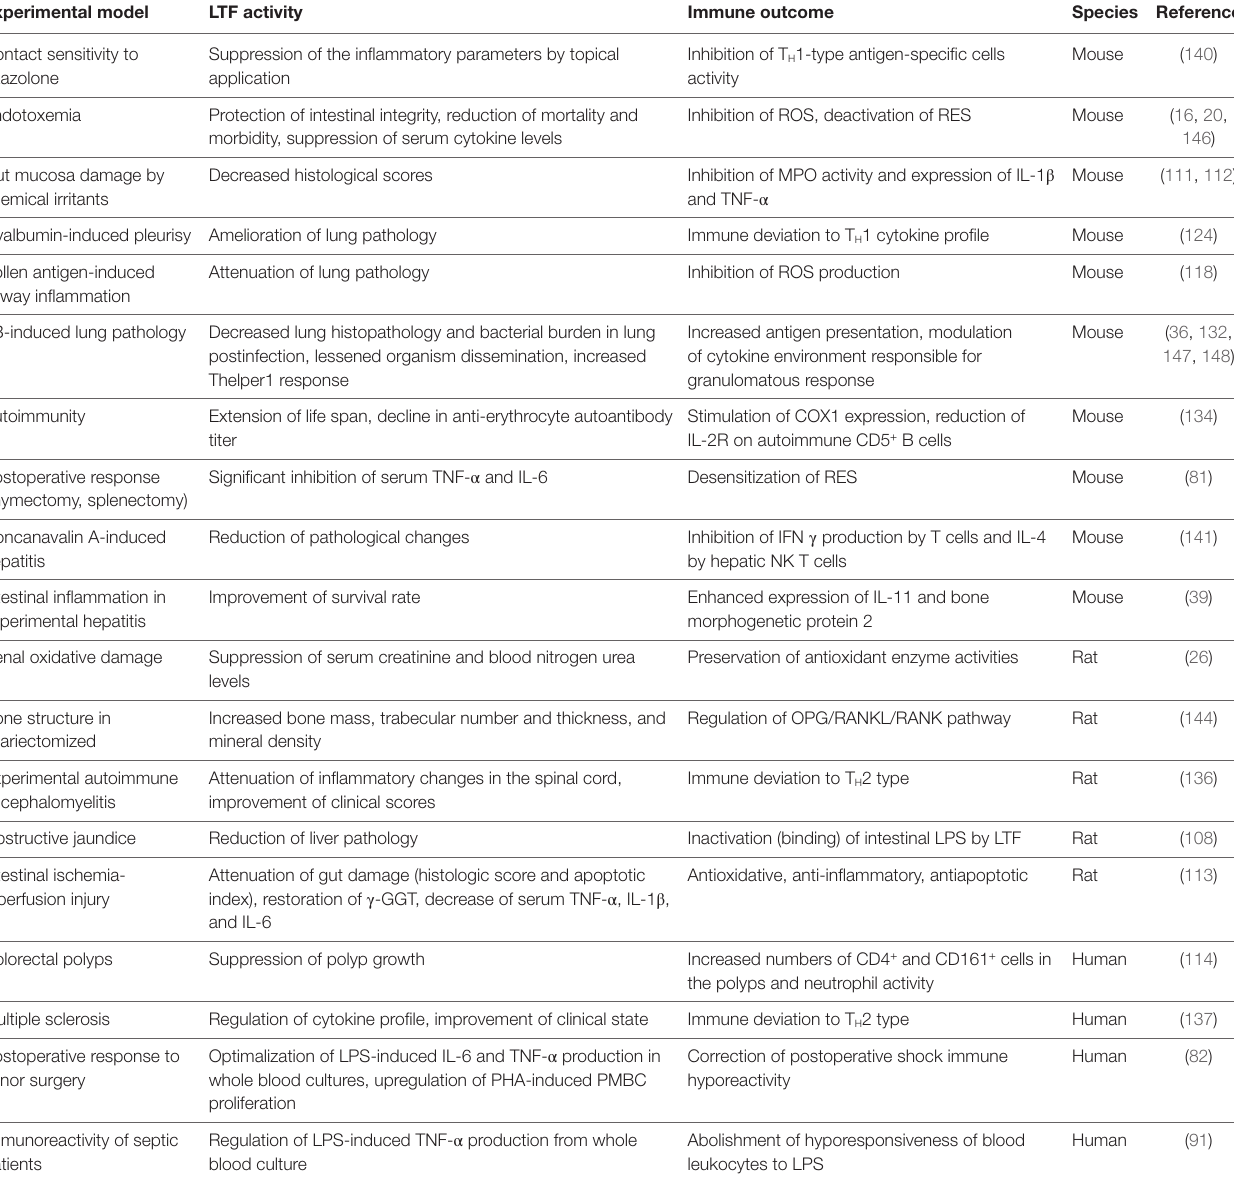
TAbLe 2 | Selected examples of lactoferrin (LTF) protective activity against defined inflammation-induced pathologies. experimental